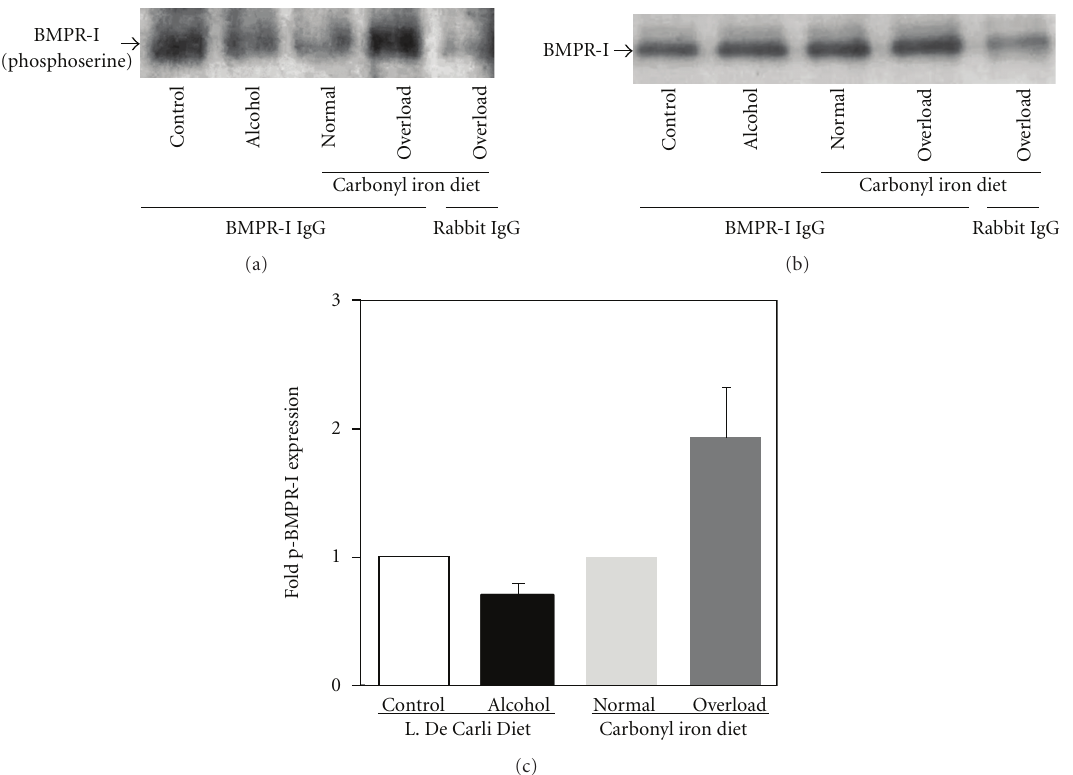
Figure 7: Activation of BMPR-I . Bone morphogenetic protein receptor type I (BMPR-I) was immunoprecipitated from the liver lysates of mice fed with regular (control) or ethanol-containing (alcohol) Lieber-De Carli liquid diets, and of mice fed with diets containing 0.2% (normal) or 2% (overload) carbonyl iron, as described in Materials and Methods. The phosphorylation of BMPR-I on serine residues in the immune complexes was determined by western blotting employing an anti-phosphoserine antibody (a), and the total levels of BMPR-I protein were detected by western blotting with an anti-BMPR-I antibody (b). (c) Autoradiographs from di ff erent experiments ( n = 2) were scanned by a densitometer, and phospho-BMPR-I (p-BMPR-I) expression in each sample was quantified by normalizing to immunoprecipitated BMPR-I protein level. Normalized p-BMPR-I expression in alcohol or high iron-fed mice was expressed as fold expression of that in the control mice or in mice fed with normal iron